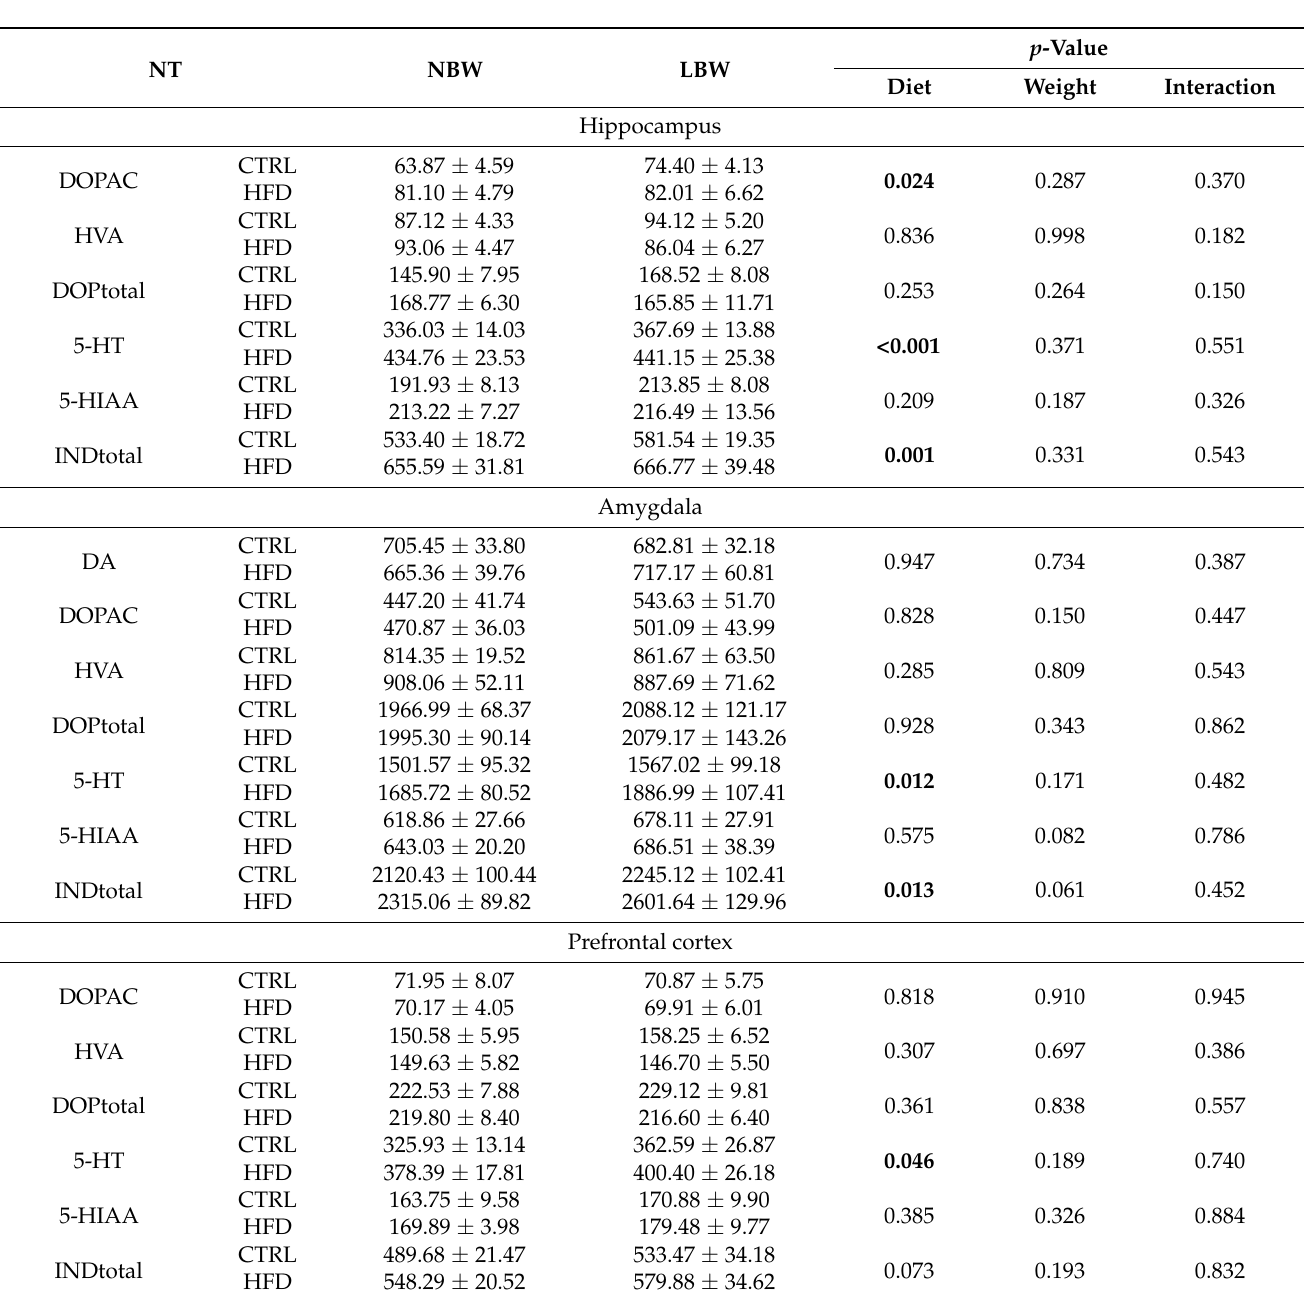
Table 1. Concentration of neurotransmitters and their metabolites (ng/g tissue) in different brain areas of 1 year-old pigs as a function of diet (Ctrl and HFD), their birth weight (NBW and LBW), and their